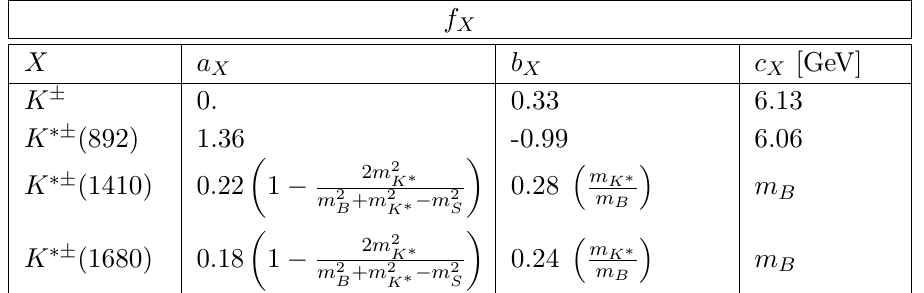
Table 1 . Values of the coefficients for the form factor f X used in this work, which were taken from [71, 72] and [73]. Here, m K ∗ is the mass of the corresponding vector kaon.